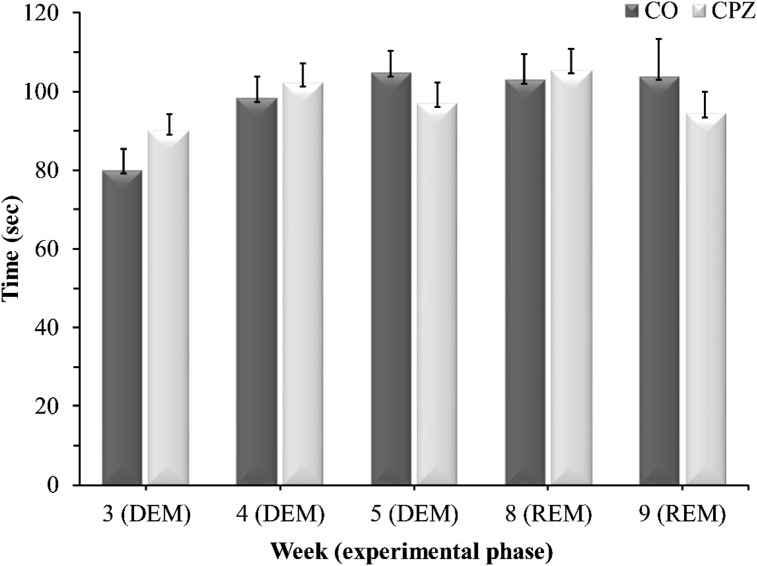
Rotarod investigation results. Data are presented as the total time spent on the rod in the CO-, DEM- and REM groups. CO control group, CPZ cuprizone treated group, DEM demyelination phase of the treated group, REM remyelination phase of the treated group, n = 18/group.